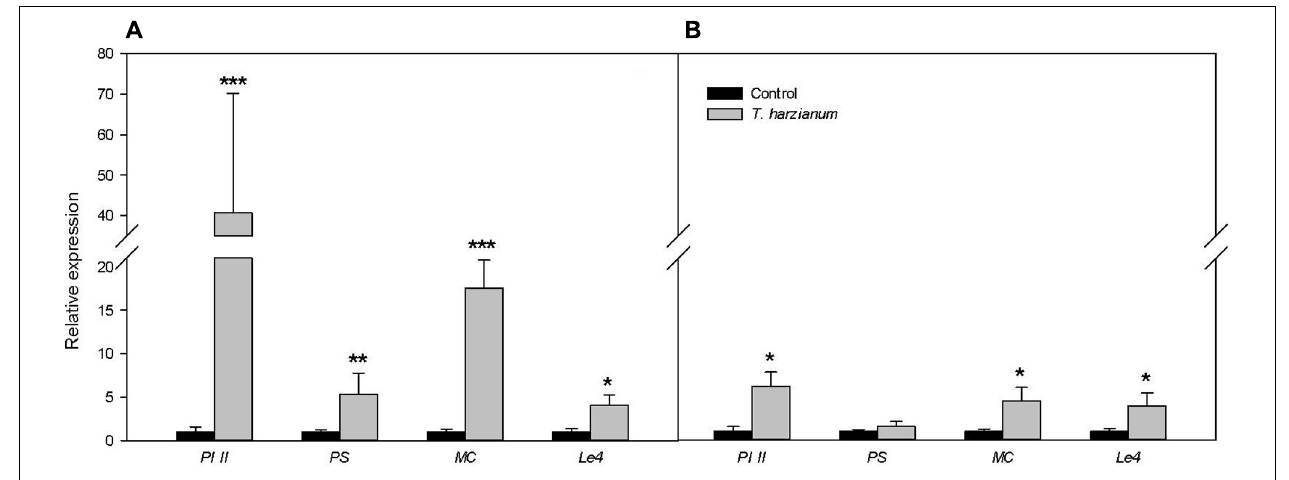
Le4 is shown.The results were normalized to the SlEF gene expression levels.The expression levels are reported as the fold increase relative to that of the control plants not treated with T. harzianum ± SE ( n = 5). Asterisks indicate statistically significant differences between Trichoderma induced and non-induced plants (Student’s t -test, * P < 0.05; ** P < 0.01; *** P < 0.001).